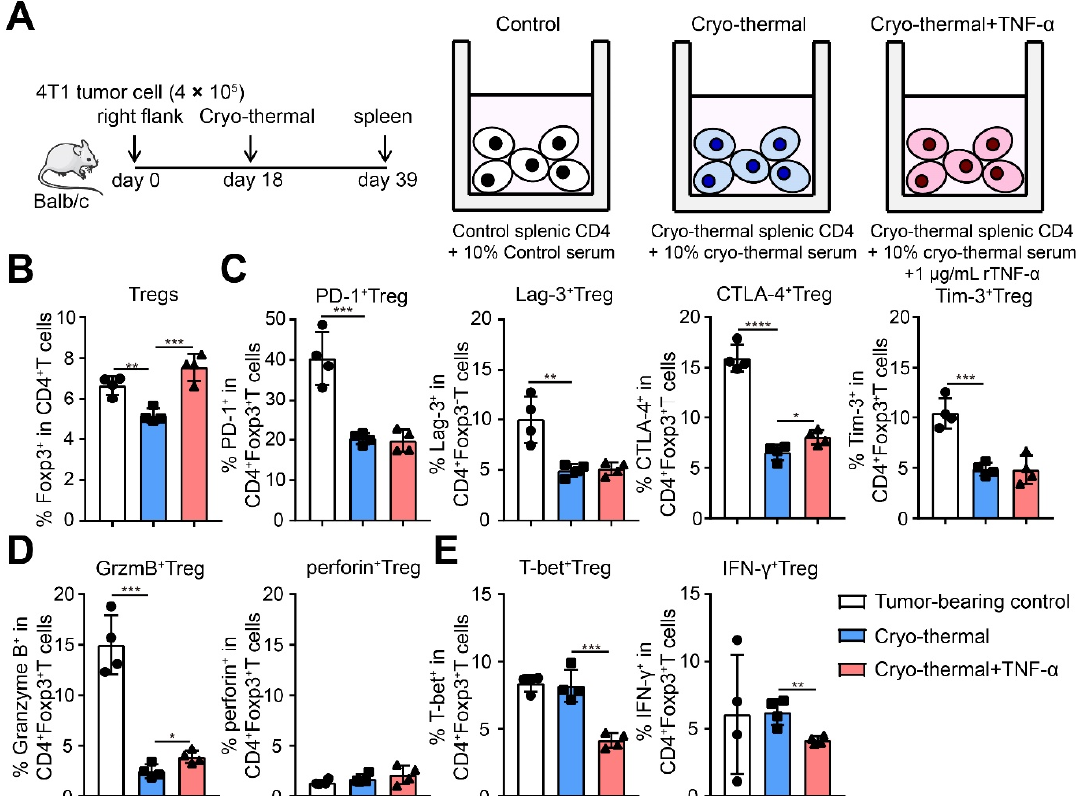
Figure 6. In vitro TNF- α supplement after cryo-thermal therapy damaged Tregs fragility and promoted tumor metastasis of mice. ( A ) Schematic of experimental design. Splenic CD4 + T cells were separated from tumor-bearing control (39 days after inoculation) or cryo-thermal treated mice (21 days after treatment) and cultured in vitro for 24 h. The serum from tumor-bearing or cryo-thermal treated mice was added in corresponding group. Recombinant TNF- α protein was added in the concentration of 1 μ g/mL. The proportion of Tregs ( B ), the expression of inhibitory checkpoints ( C ), the expression of suppressive cytokines ( D ), and the expression of T-bet, IFN- γ of Tregs ( E ) were detected by flow cytometry. n = 4 for each group. * p < 0.05, ** p < 0.01, *** p < 0.001, **** p < 0.0001.